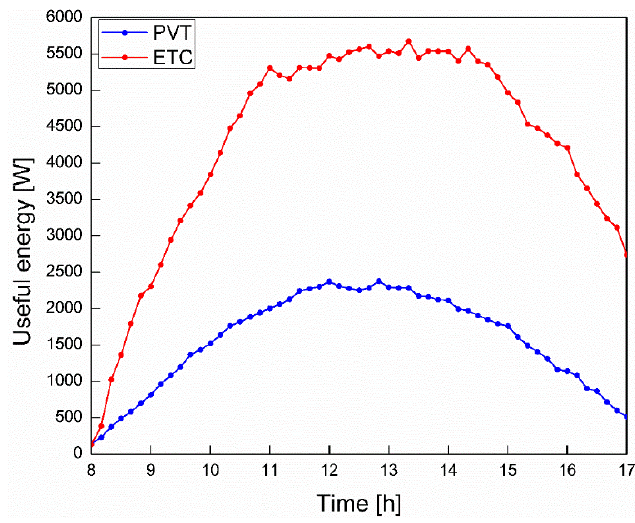
Figure 5. Useful thermal energy produced by the collectors.